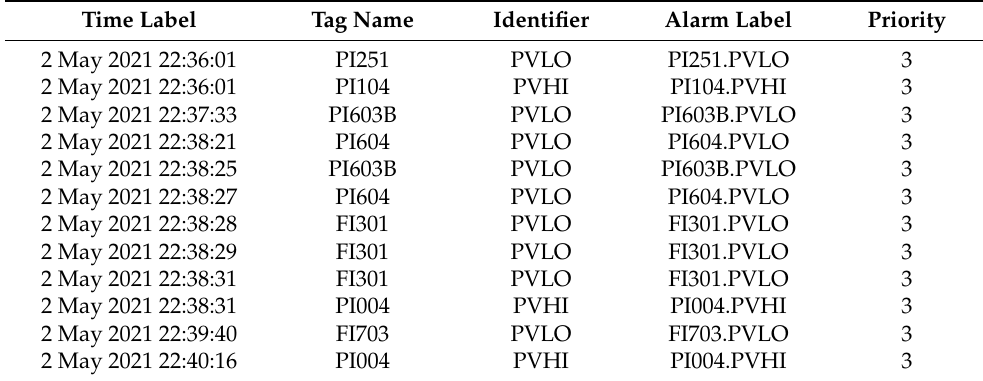
Table 1. An example of alarms in industrial plants.